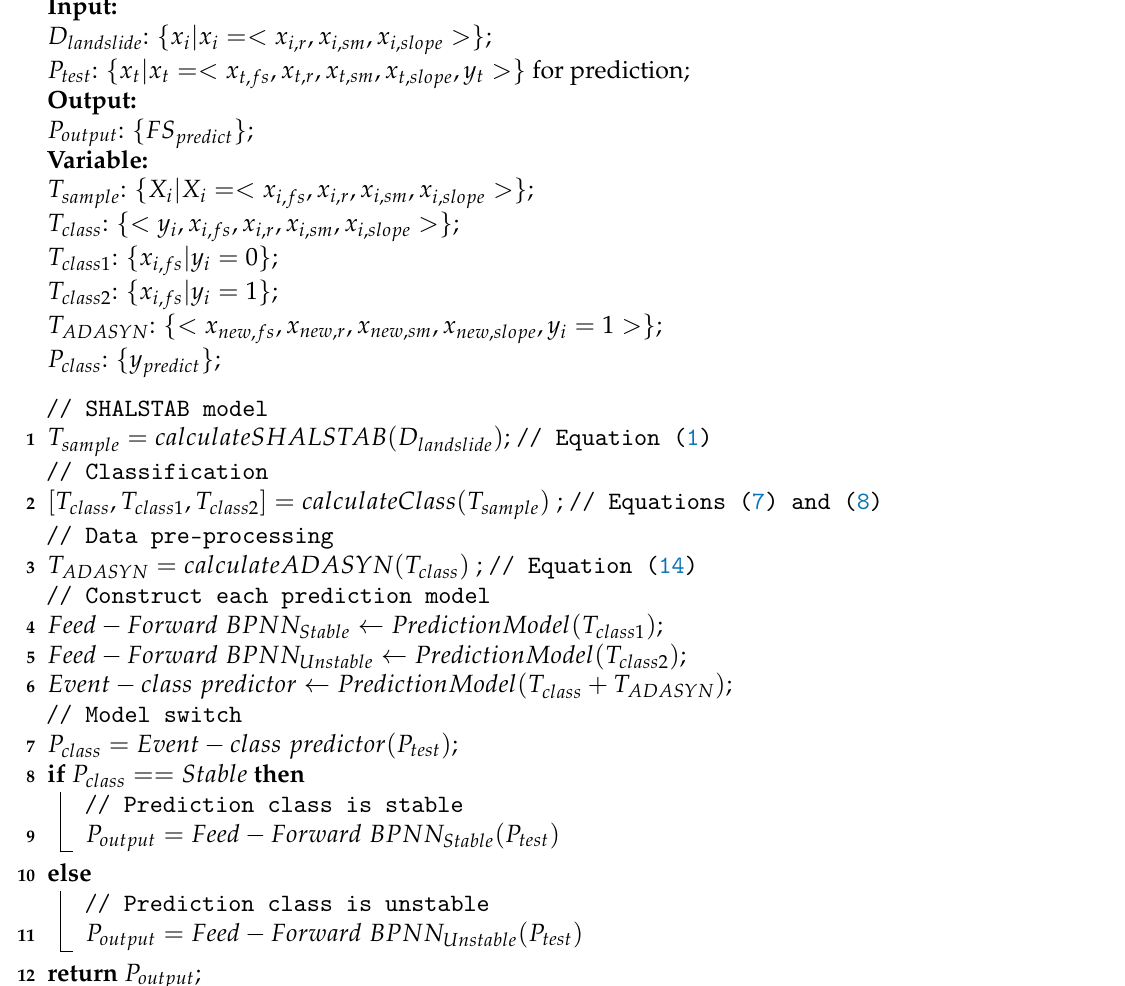
Algorithm 2: Switch-based Neural Networks Prediction